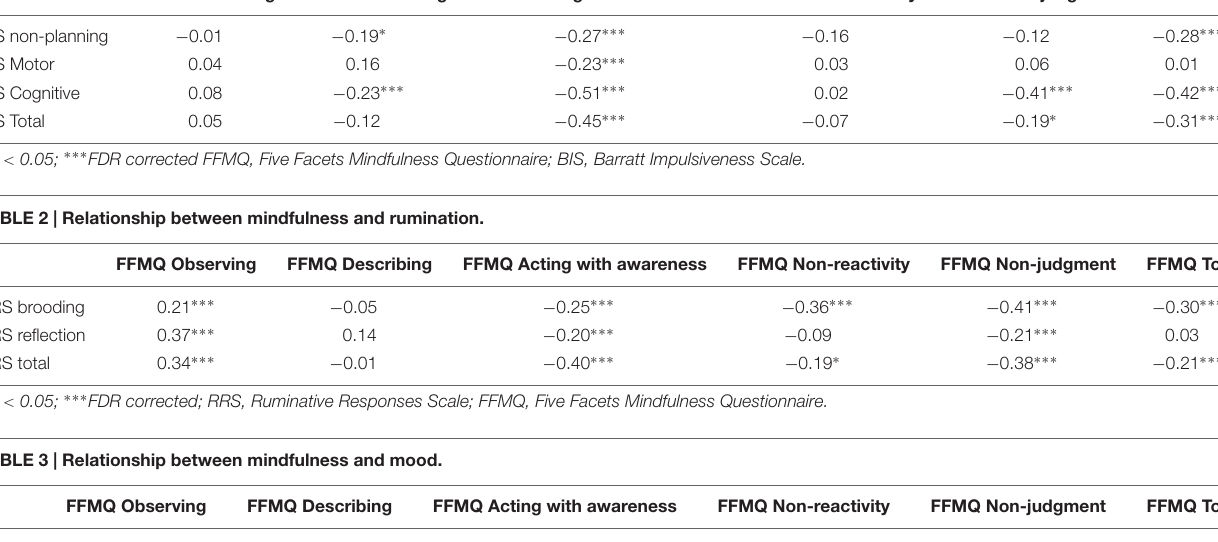
FIGURE 2 | Performance in the production task as function of the duration and the SOA. TABLE 1 | Relationship between mindfulness and impulsivity. FFMQ Observing FFMQ Describing FFMQ Acting with awareness FFMQ Non-reactivity